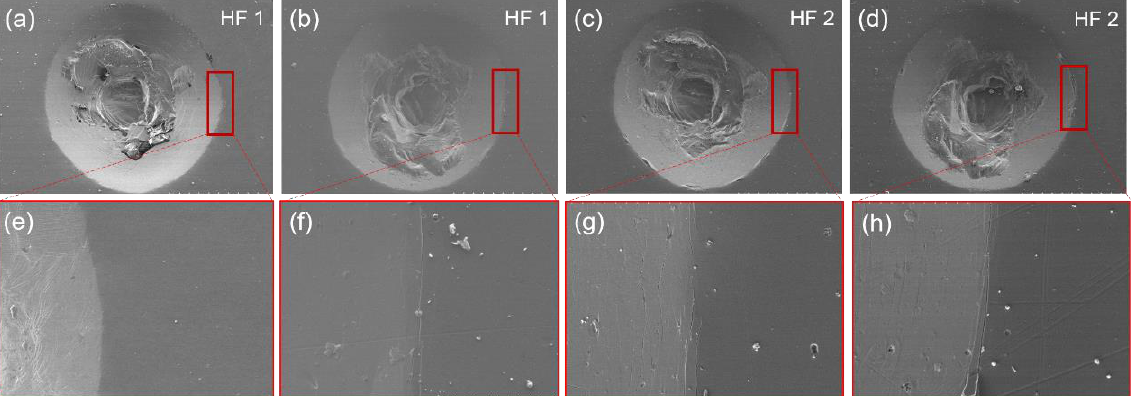
Figure 11. SEM morphology of Rockwell C indentation of the TiAlN coatings deposited at a nitrogen flux rate of ( a , e ) 0, ( b , f ) 40, ( c , g ) 50 and ( d , h ) 60 sccm.